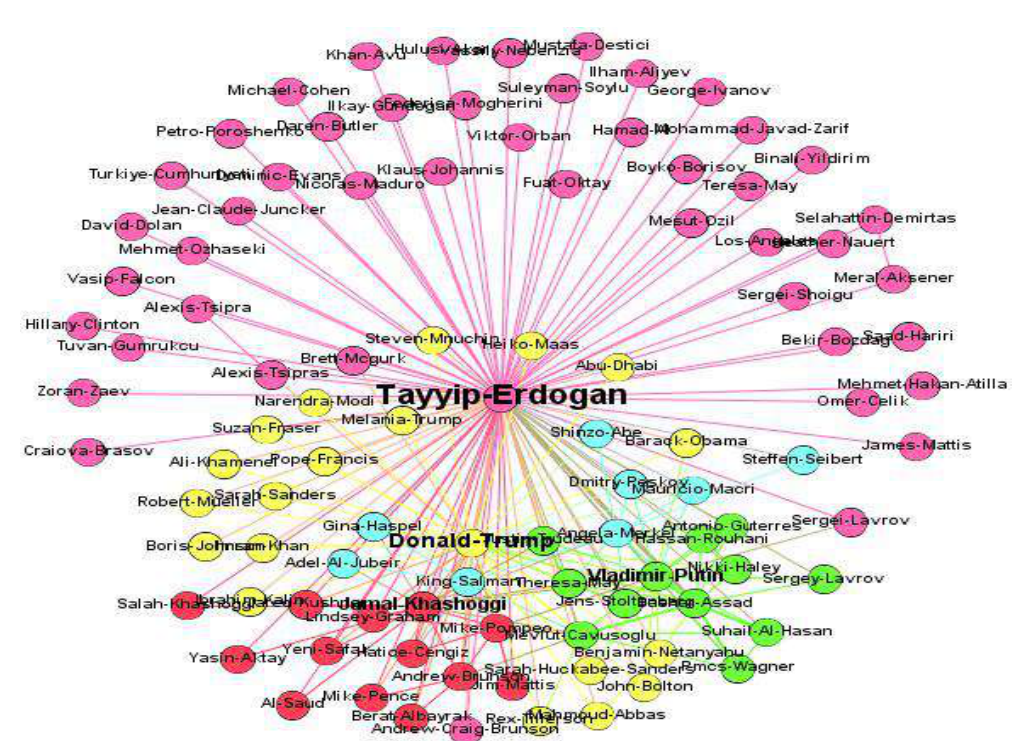
Figure 17: Modularity 2018 (Source: Authors ‟